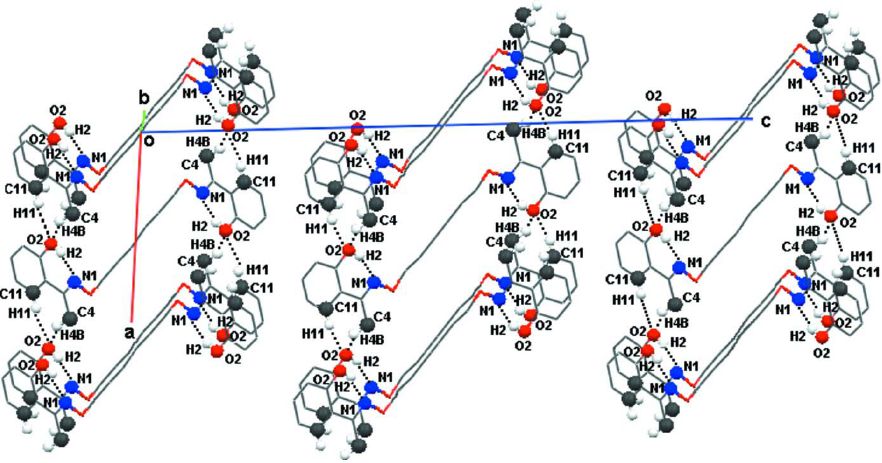
The molecular structure of the title compound with the atom numbering scheme [Symmetry codes: - x , - y + 2, - z + 1]. Displacement ellipsoids for non-hydrogen atoms are drawn at the 30% probability level.